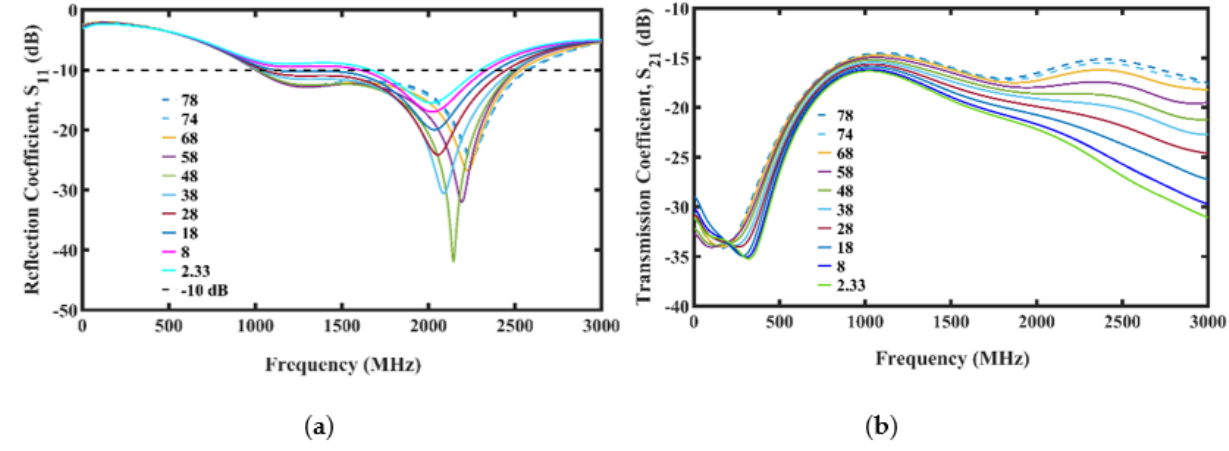
Figure 5. Simulation plot of oil spill. ( a ) Reflection Coefficient. ( b ) Transmission Coefficient.